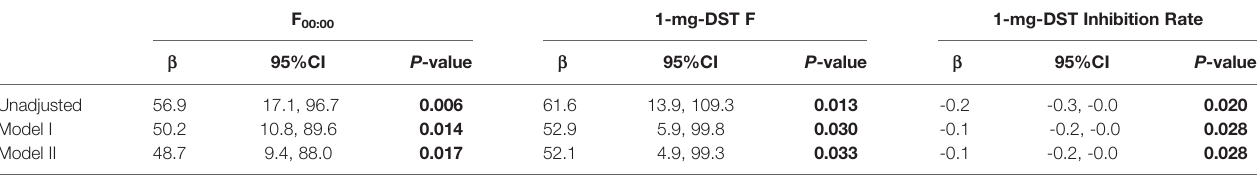
TABLE 2 | Logistic regression used to analyze the difference in autonomous cortisol secretion between male and female MACS patients. F